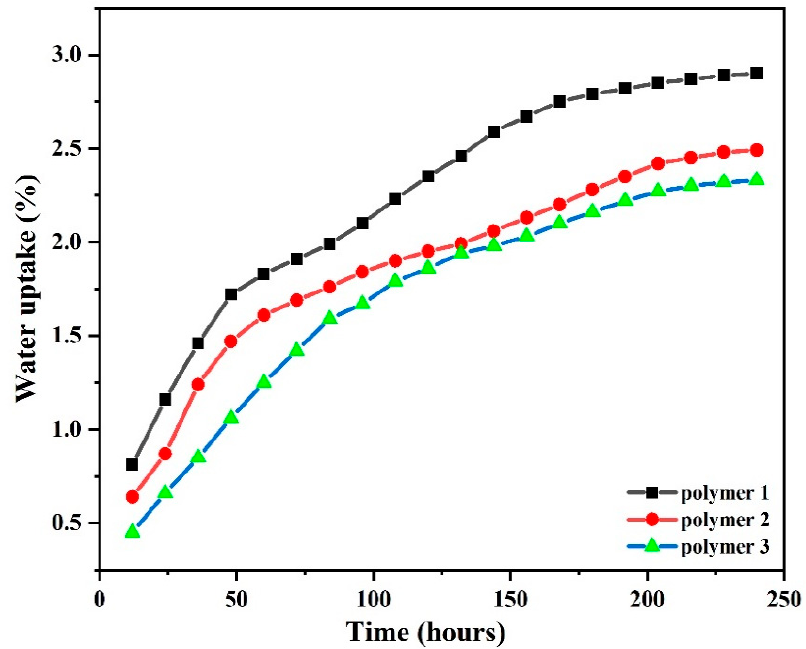
Figure 19. Water uptake of DPTP polymers.